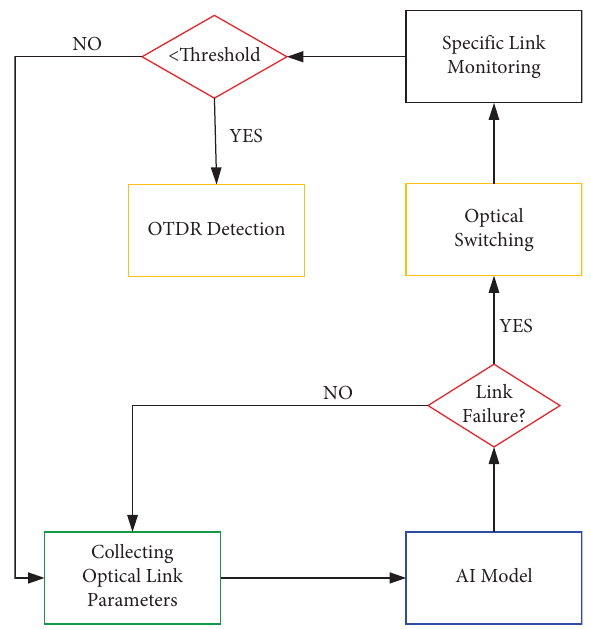
Figure 2: Workfow of the proposed